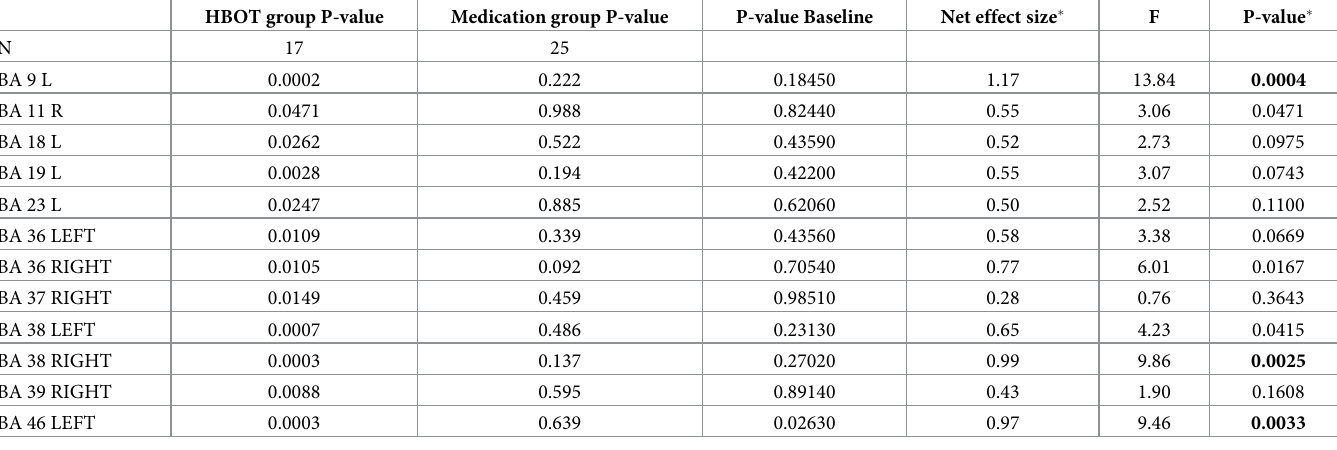
Table 3. Increased post treatment activation in Brodmann areas (BAs)–SPECT